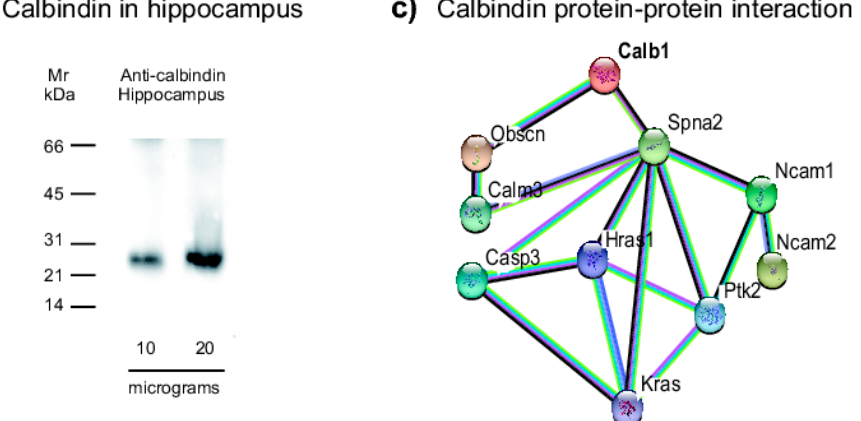
Figure 1. Calbindin distribution along the dentate gyrus. ( a ) Mossy fiber projections were visualized with an anti-calbindin antibody. Bright fields also show the granule cell layer (GCL), subgranular zone (SGZ), hilus (H), molecular layer (ML), suprapyramidal (SPMFPs), infrapyramidal-mossy fiber projections (IPMFPs), and Cornu Ammonis 3 (CA3), respectively. Scale bar in ( a ) = 150 µm. ( b ) Western blot analysis of whole hippocampus protein lysates to identify calbindin within a 28 kDa of molecular weight. ( c ) Functional protein association network obtained from String database (https://string-db.org) is shown. The map shows the interaction of calbindin (Calb1) with Spna2 (fodrin) and Obscn (obscurin) that establishes the interaction with Ras proteins (Hras1, Kras), protein tyrosine kinase (Ptk2), and neural cell adhesion molecule (Ncam).